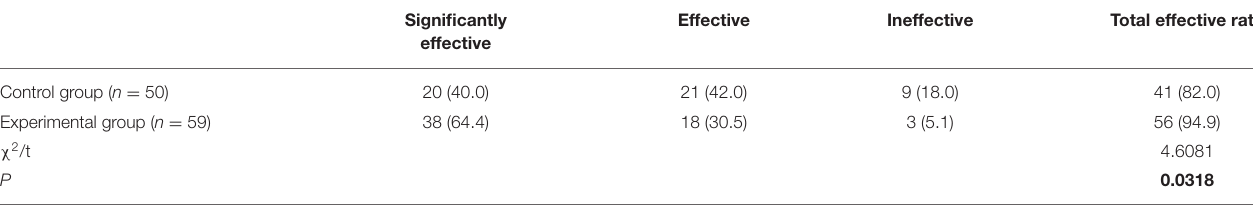
TABLE 3 | Comparison of therapeutic effect of patients between the two groups.